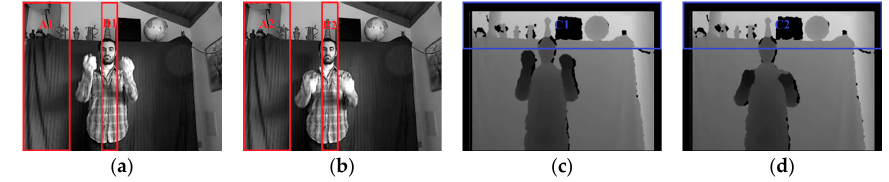
Figure 1. Two pairs of consecutive gesture frames captured at time t and t + 1. ( a ) Grayscale frame G t ; ( b ) Grayscale frame G t + 1 ; ( c ) Depth frame D t ; ( d ) Depth frame D t + 1 . Noise exists in regions A1, A2,